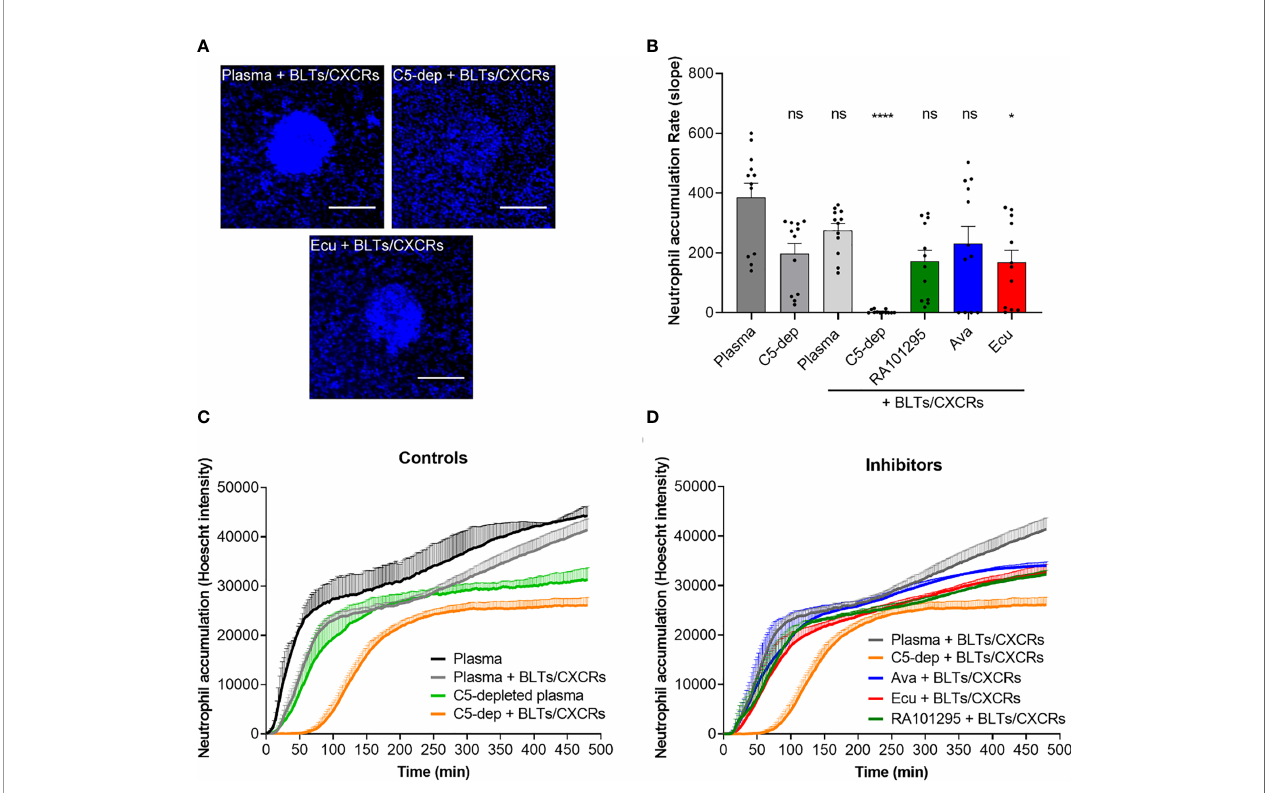
FIGURE 5 | Evaluation of C5-inhibitors guiding neutrophil migration during swarming towards zymosan particle clusters. (A) Microscopic fl uorescent images of neutrophil recruitment and swarm formation after one hour in plasma, C5-depleted, and ECU treated plasma with neutrophils pretreated with LTB4 (BLTs) and IL8 (CXCRs) inhibitors. Neutrophils nuclei are labeled in blue (Hoechst 33342). The scale bar is 100 µm. (B) Effect of C5 inhibition of plasma with ECU, AVA, and RA10129 on swarming kinetics. Only the effect of ECU reached statistical signi fi cance relative to untreated plasma. Each dot represents the slope value of each zymosan-particle cluster during the fi rst hour (*p < 0.05, ****p < 0.0001; Kruskal-Wallis with Dunn ’ s test). (C) Neutrophil recruitment and accumulation kinetics over time in plasma and C5-depleted plasma in the absence or presence of LTB4 (BLTs) and IL8 (CXCRs) inhibitors neutrophil pre-treatment (N=3). (D) Neutrophil recruitment and accumulation kinetics over time in plasma pretreated with ECU, RA101295, or AVA in the presence of LTB4 (BLTs) and IL8 (CXCRs) inhibitors neutrophil pre-treatment (N=3). ns represents not statistical signi fi